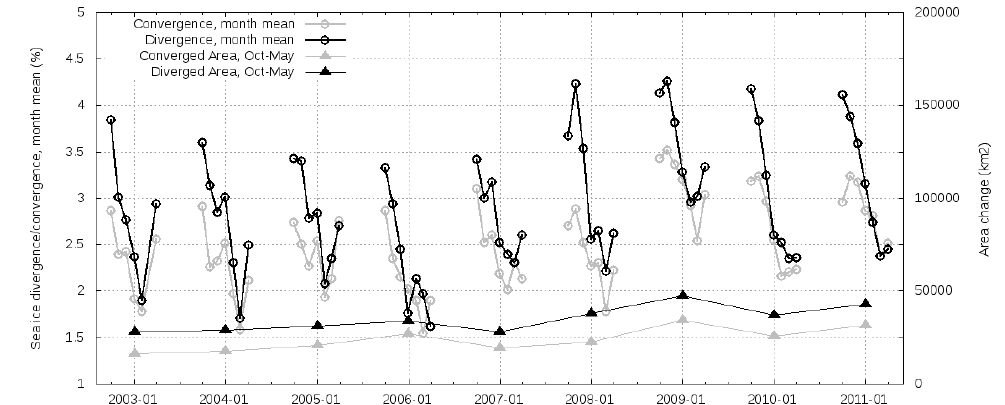
Figure 11: Monthly mean values of Western Arctic 48 hour sea ice divergence (black lines and circles) and convergence (grey lines and circles), during seven winter month (October–May) since 2002. Mean values are based on daily divergence fields calculated from AMSR-E ice drift fields using the CMCC algorithm. The ice convergence values are negative divergence values, but plotted here as absolute values for comparison to positive divergence values. The associated diverged and converged areas are plotted as aggregated winter (October–May) values in square kilometres (black and grey triangles, respectively).